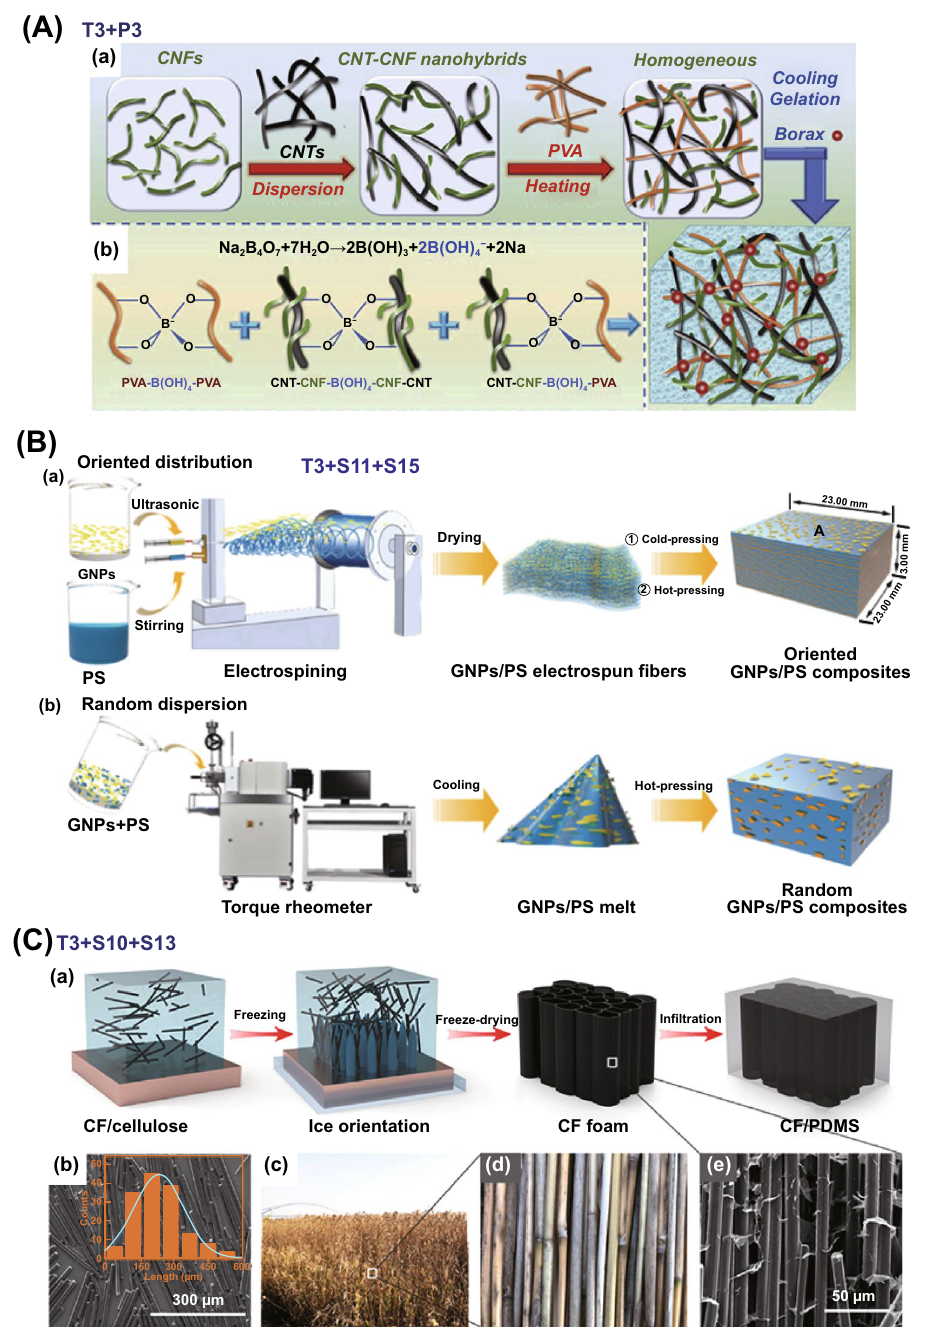
Fig. 11 A Schematic illustration of the preparation procedure of carbon nanotube/cellulose nanofiller/polyvinyl alcohol (CNT-CNF/PVA) com- posite gels. Reprinted with permission from Ref. [156]. B Schematic presentation of graphite nanoplatelets/polystyrene (GNPs/PS) composites with interconnection oriented GNPs network ( b ). Reprinted with permission from Ref. [169]; C Preparation of carbon fibers/ polydimethylsilox- ane (CF/PDMS) composites to obtain vertical CF foam microstructure. Reprinted with permission from Ref.